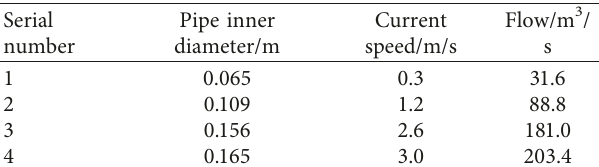
Table 4: Corresponding value of pipe diameter, flow velocity, and flow.